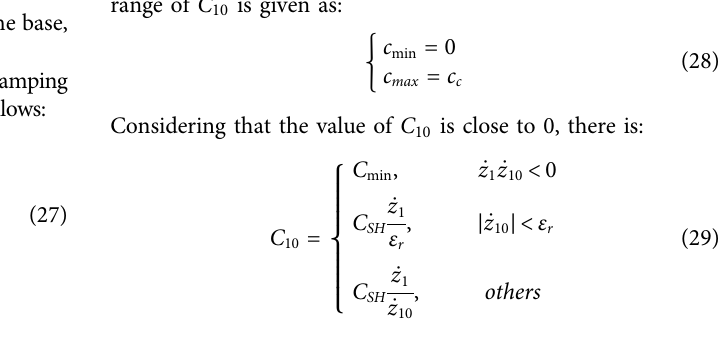
Frontiers in Materials |